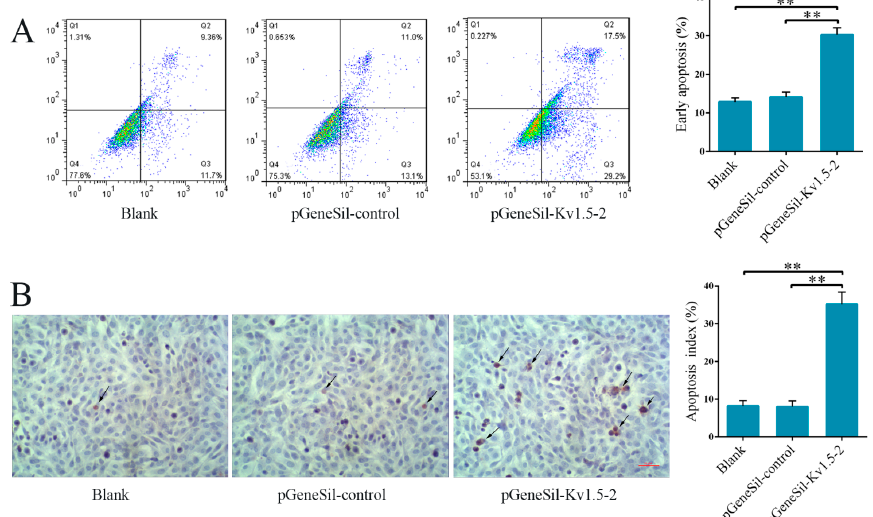
Figure 5. The influence of Kv1.5 knockdown on osteosarcoma cell apoptosis. ( A ) MG-63 cells were